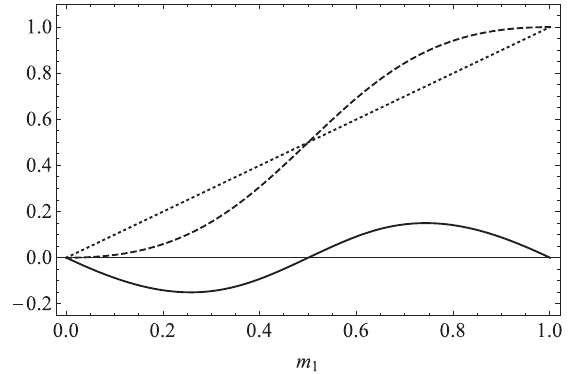
FIG. 1. Dashed line shows the function p 1 ð m Þ ≡ f 1 , defined by Eq. (4) for the V ¼ 2 model with conformity number β ¼ 2 . Dotted line shows the neutral version p 1 ð m Þ ¼ m 1 (when β ¼ 1 ) for comparison. Solid line shows the function p 1 ð m Þ − m 1 in the case β ¼ 2 , giving the time derivative of the memory in the absence of spatial variation. Note that the dashed line shows that when speakers ’ memories contain a majority of variant 1, they use this variant in a greater proportion than they recall it being used. This leads to progressively greater levels of conformity: more speakers using variant